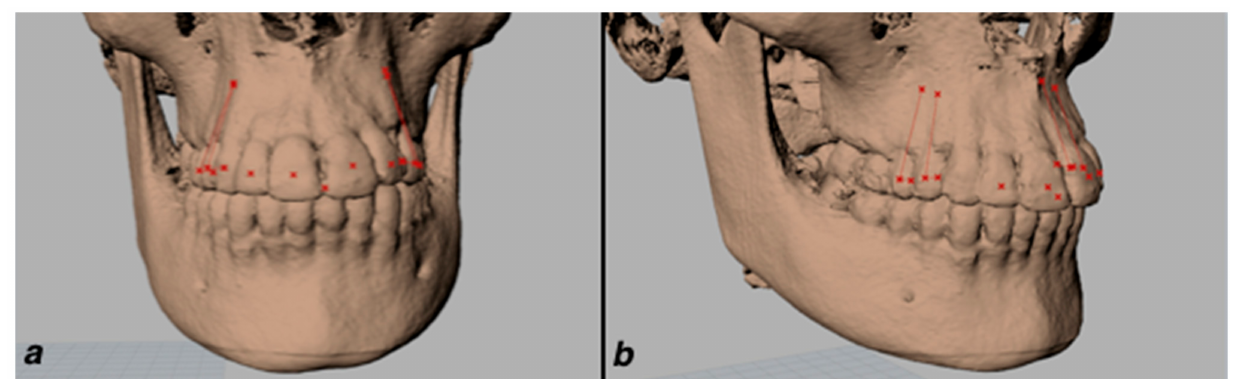
Figure 2. Proper vertical axis and Proper horizontal axis of upper premolars on CBCT. The Proper vertical axis was defined from Apex to Facial Axis Clinical Crown (FACC) and the Proper horizontal axis from FACC to Occlusal Frontal ( a ) and lateral ( b )